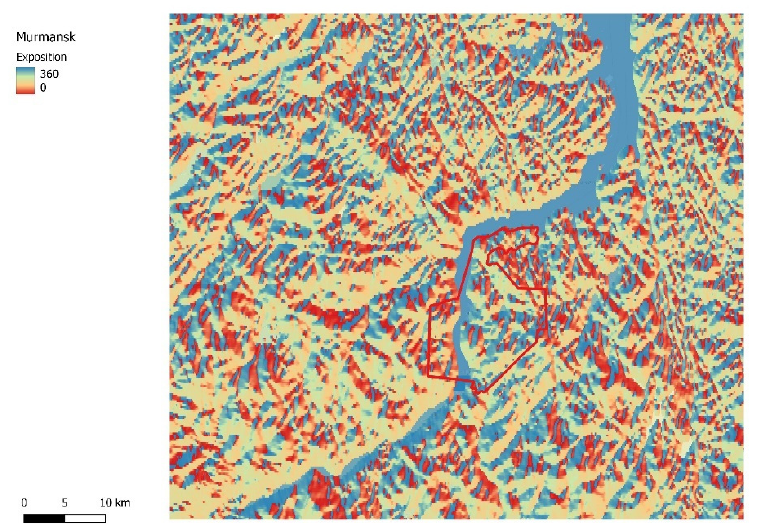
Figure 5. The case of GIS analysis of the slope exposure of settlements in the Arctic zone of the Russian Federation; part of the territory of the Murmansk region.